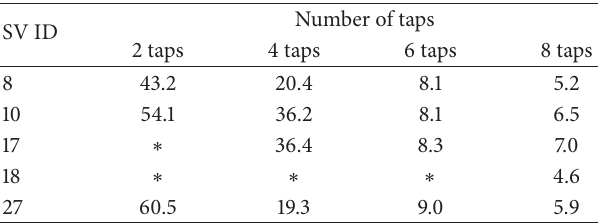
Table 8: Measurement errors using distortion metric without noise (six CW Scenario 4) (in meters).